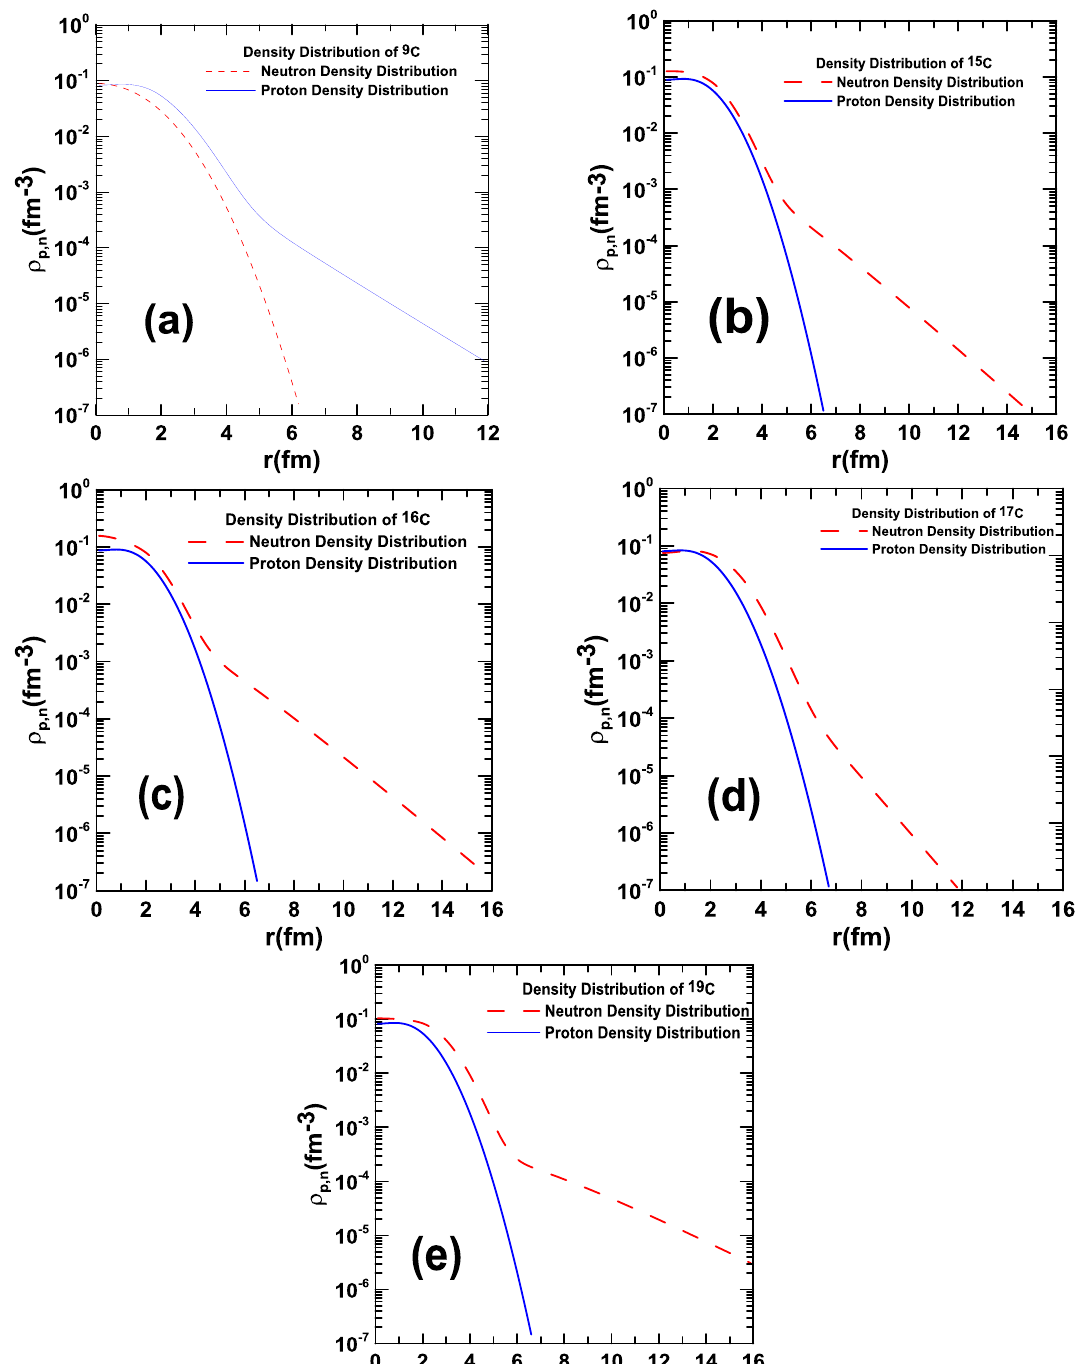
Fig. 2: The neutron and proton density distributions for carbon isotopes